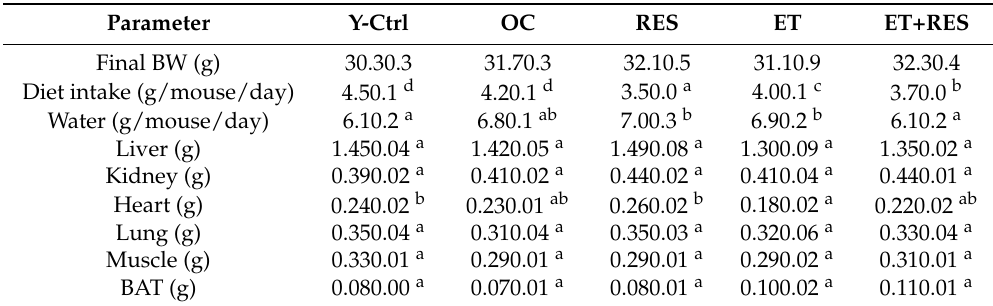
Table 1. Effects of 4-week resveratrol (RES) supplementation and exercise training (ET) on the body weight (BW), diet intake, water intake, and tissue changes in